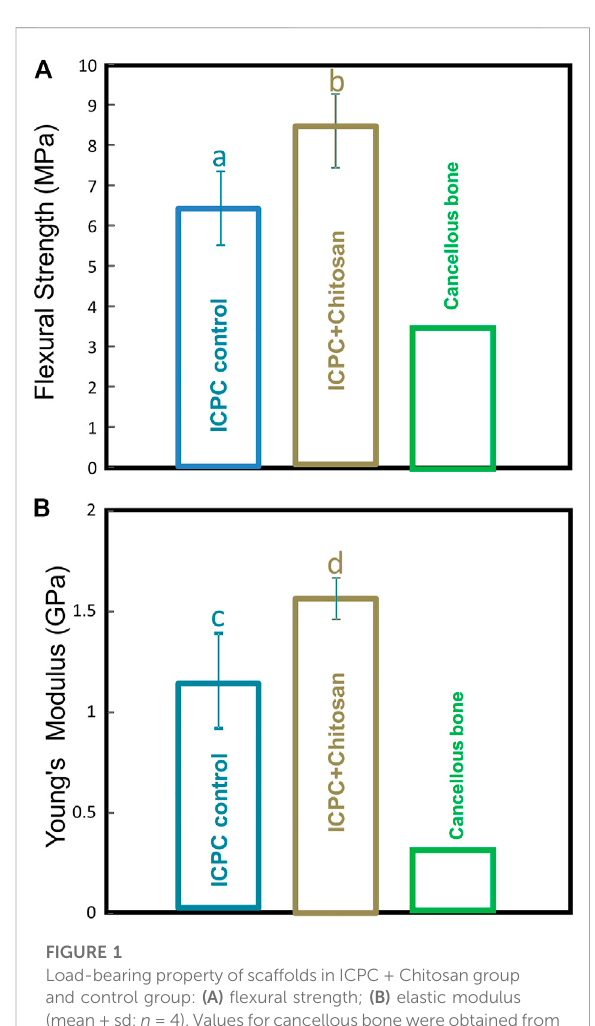
FIGURE 1 Load-bearing property of scaffolds in ICPC + Chitosan group and control group: (A) fl exural strength; (B) elastic modulus (mean±sd; n =4).Valuesforcancellousbonewereobtainedfrom the literature (Damien and Parsons,